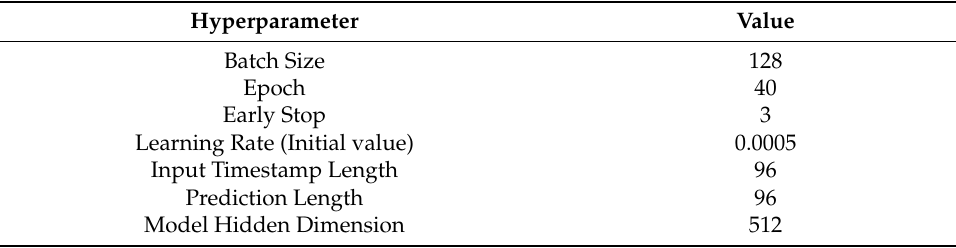
Table 1. Training Hyperparameter Configuration.